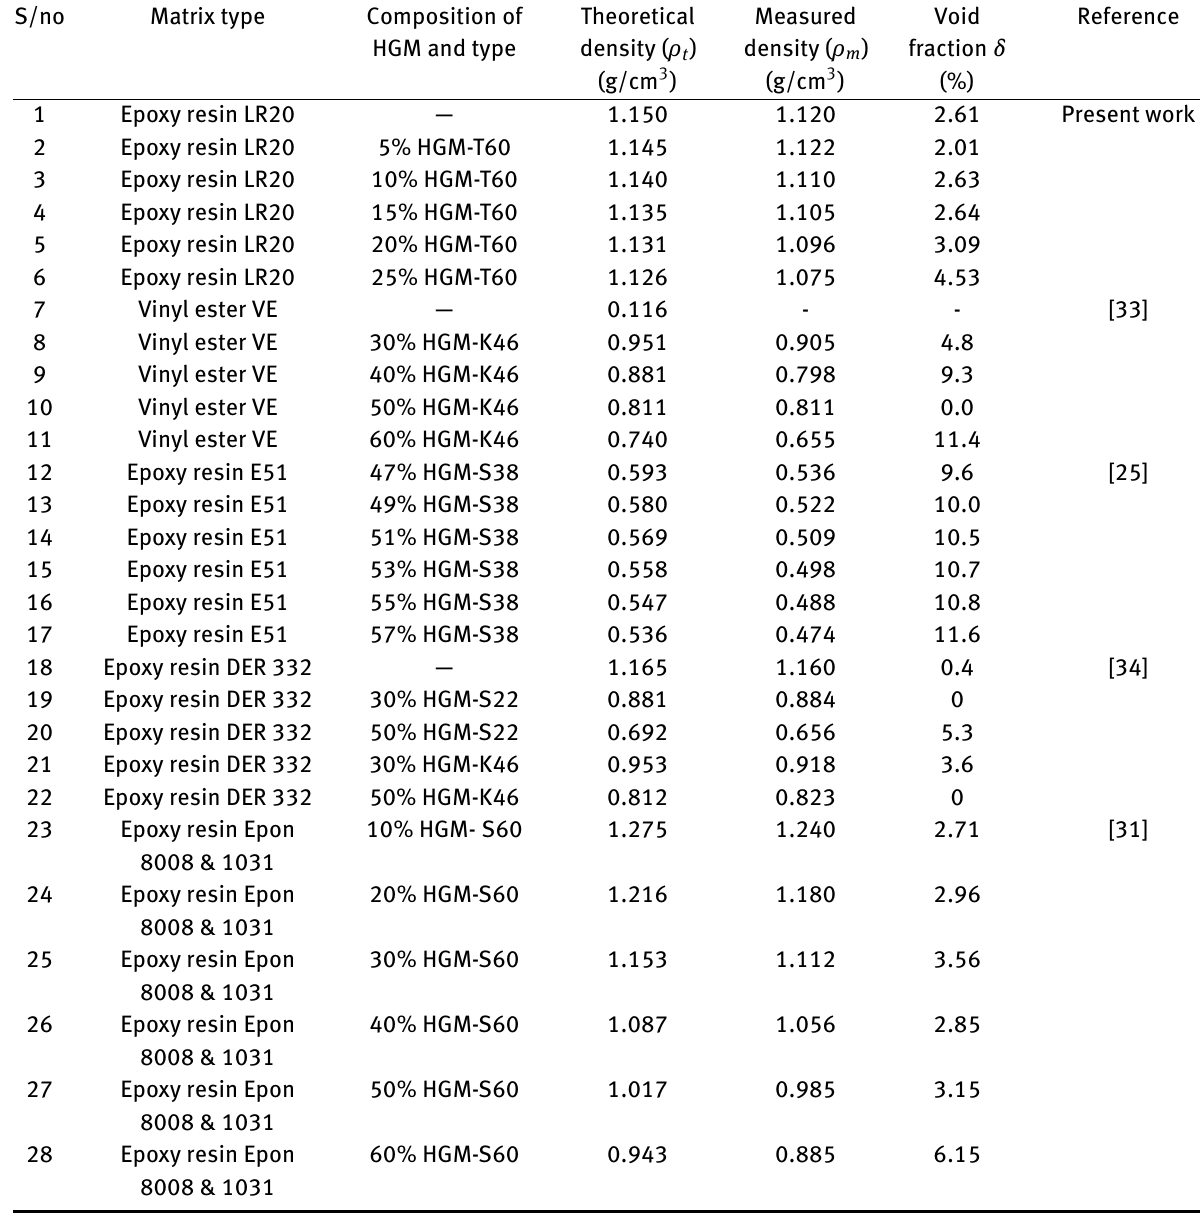
Table 2: Comparison of density and porosity (void) values of syntactic foam composites based on the present work and existing literatures.